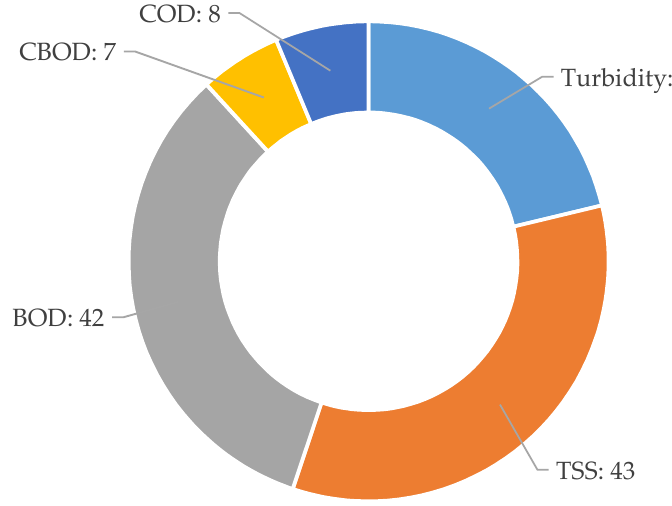
Figure 7 . The number of regulations and guidelines which included different agronomic parameters.